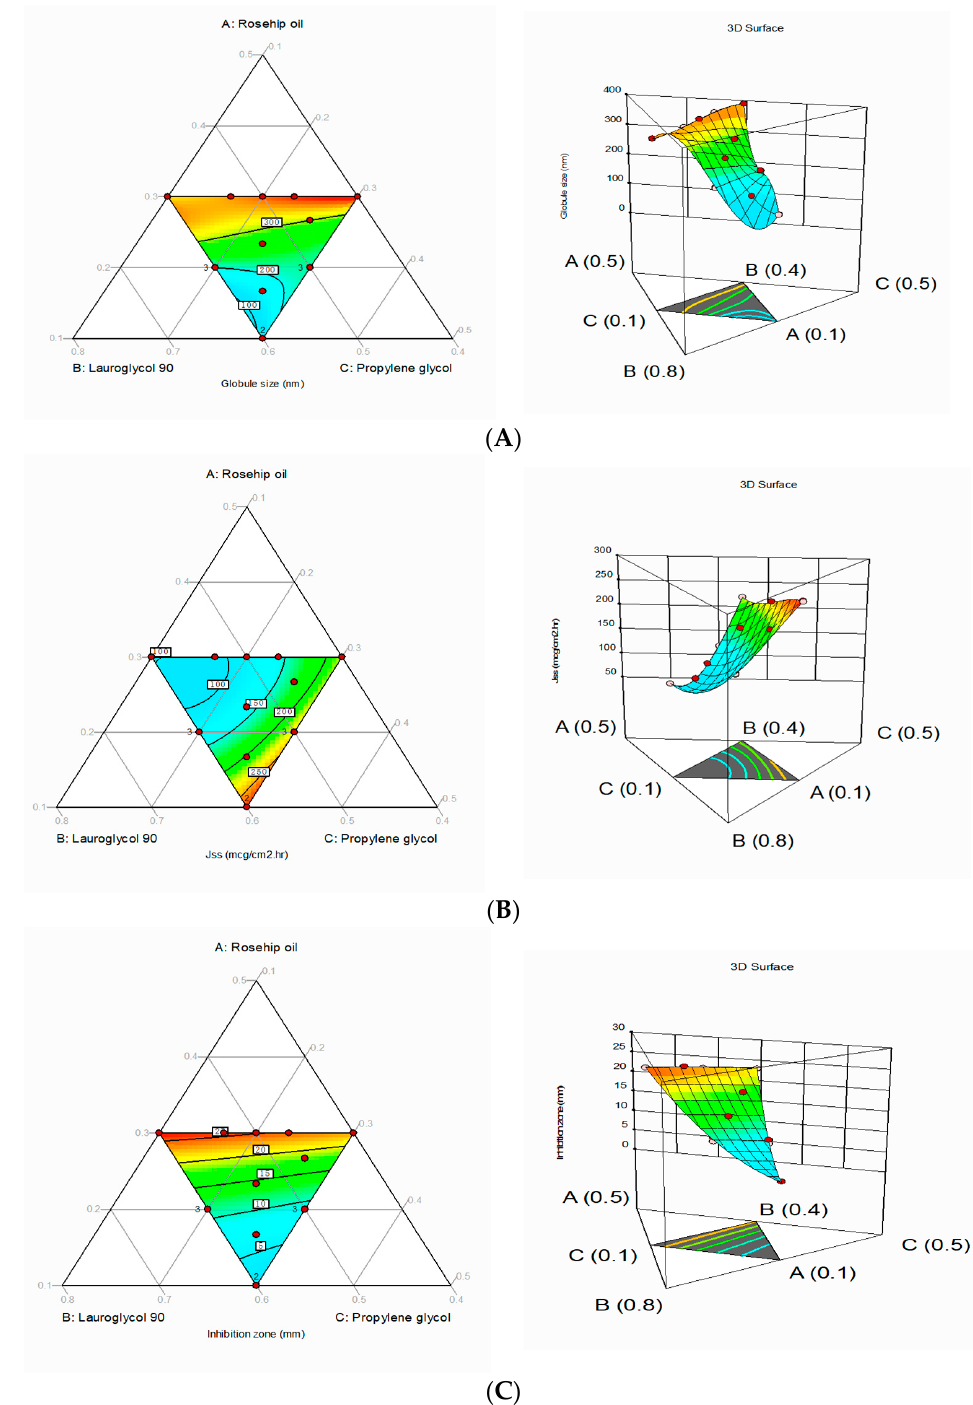
Figure 4. Contour and three-dimensional response surface graphs for ( A ) globule size, ( B ) Jss, and ( C ) inhibition